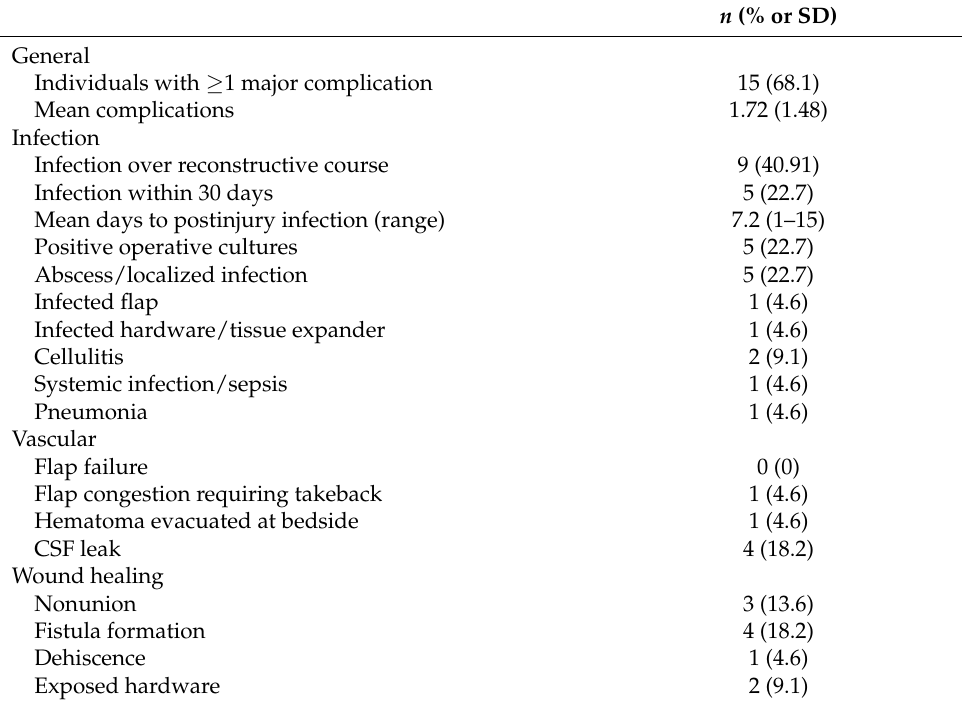
Table 5. Patient cohort major complications (N =